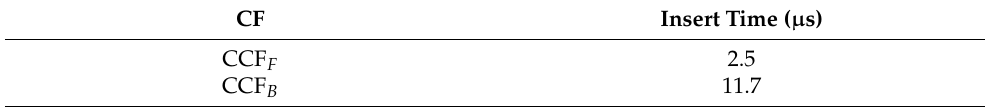
Table 4. The average insert overhead of CCF F and CCF B ( µ s).